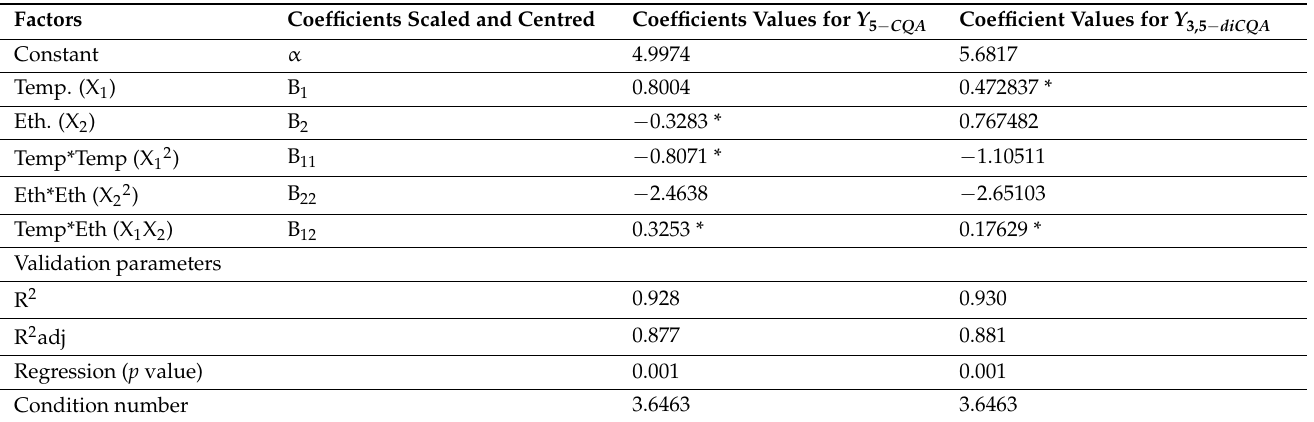
Table 4. 5-CQA and 3,5-diCQA statistical parameters of the model